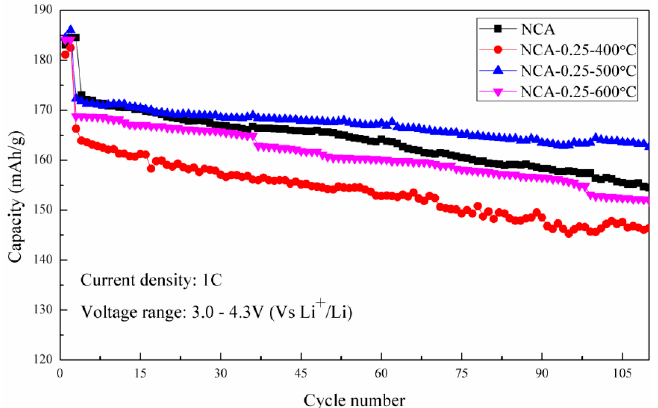
Figure 4. Cyclic performance of the pristine NCA sample and NCA-0.25 samples at different calcination temperatures from 400 °C to 600 °C.